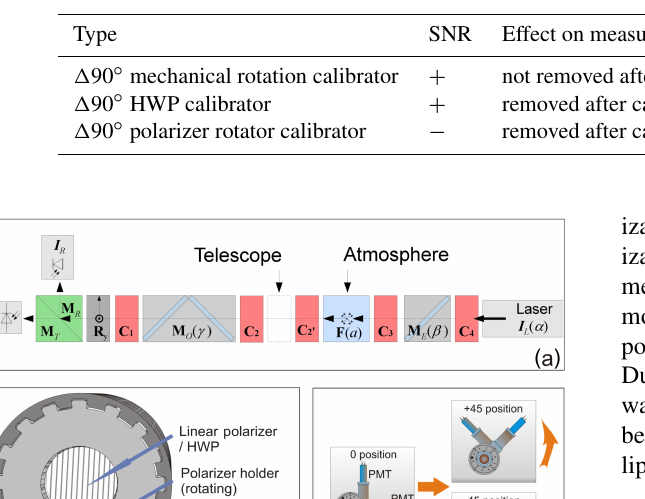
Table 1. (cid:49) 90 ◦ calibration methods. “ + ” shows advantage and “ − ” shows disadvantage over other presented methods.